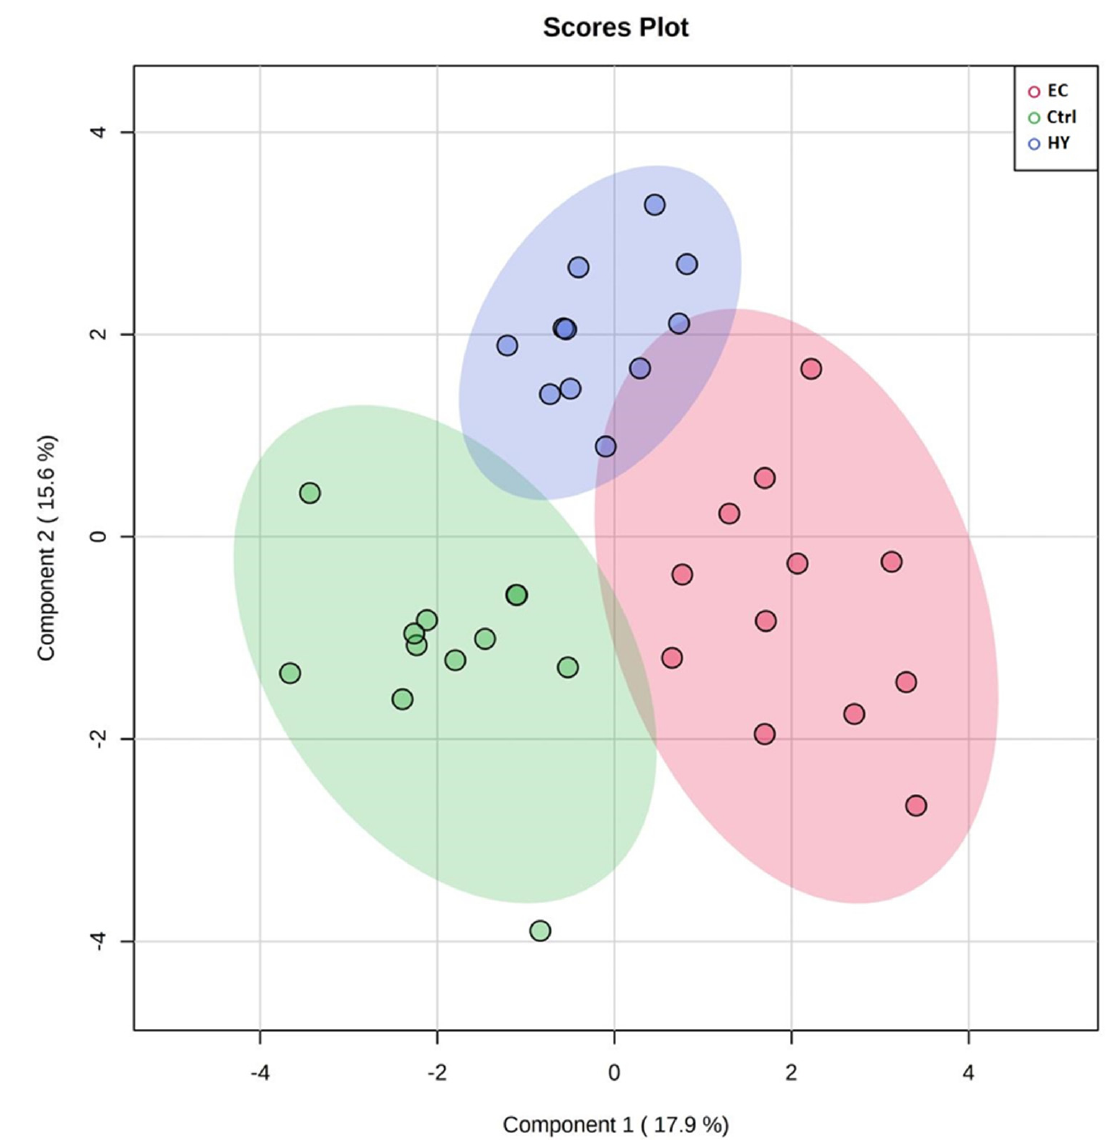
Figure 2. Two − dimensional principal component analysis (2D PCA) scores plots of significant differentially expressed proteins identified between the three groups of the study. The Ctrl, HY, and EC samples are represented as green, blue, and red circles, respectively.